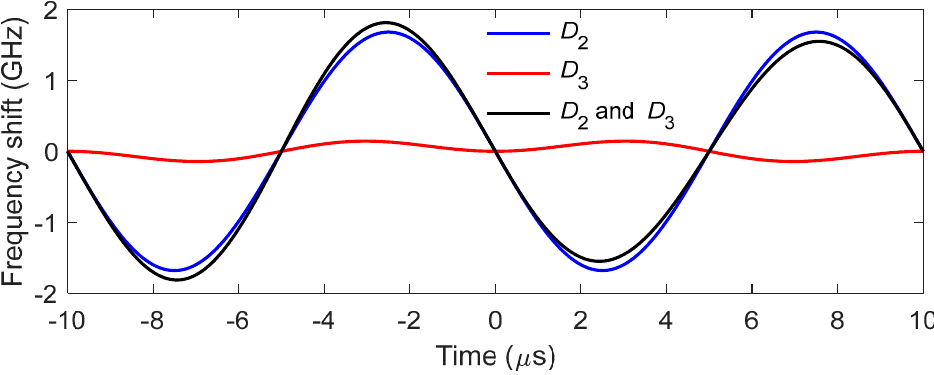
Figure 7. Relative frequency shift induced by dispersion after propagation in 4 km SMF. The blue, red and black solid curves represent the frequency shifts caused by D 2 , D 3 and their combined effect, respectively.